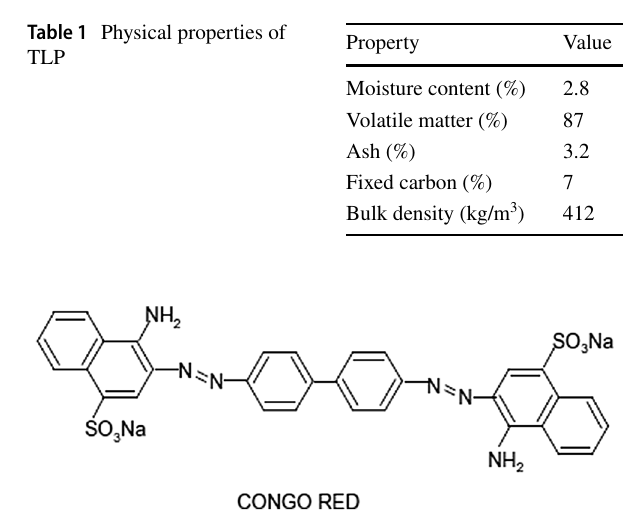
Fig. 1 Chemical structure of Congo red (CR)